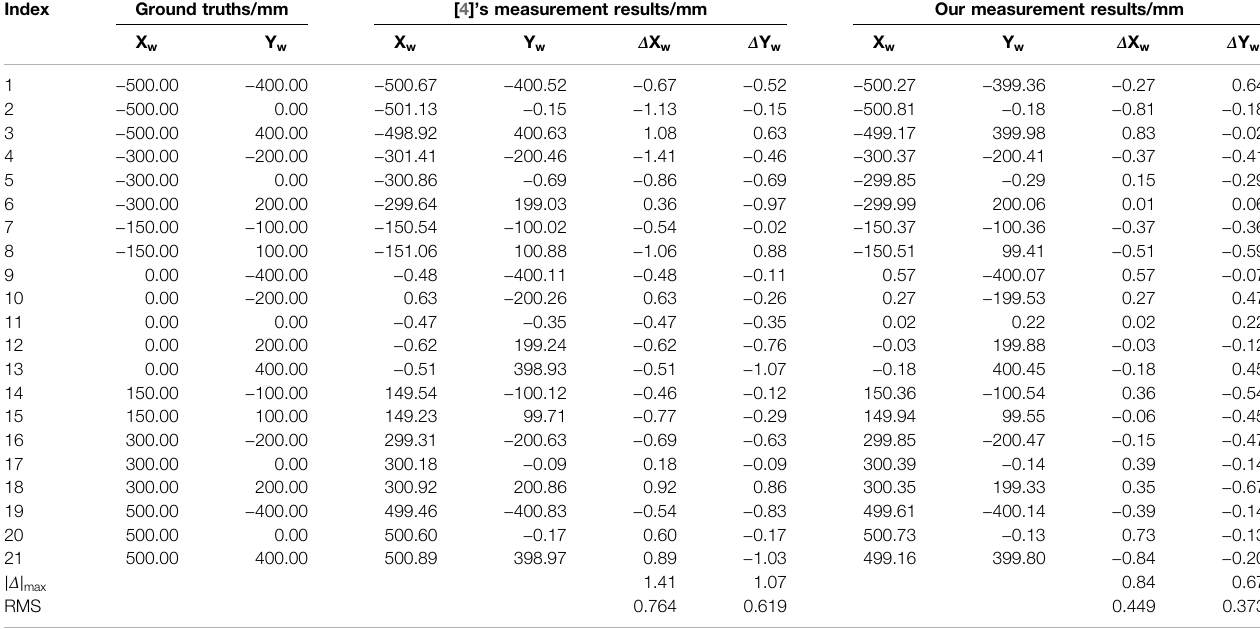
TABLE 2 | Comparisons of methods for 2D coordinate measurement. Index Ground truths/mm [4] ’ s measurement results/mm Our measurement